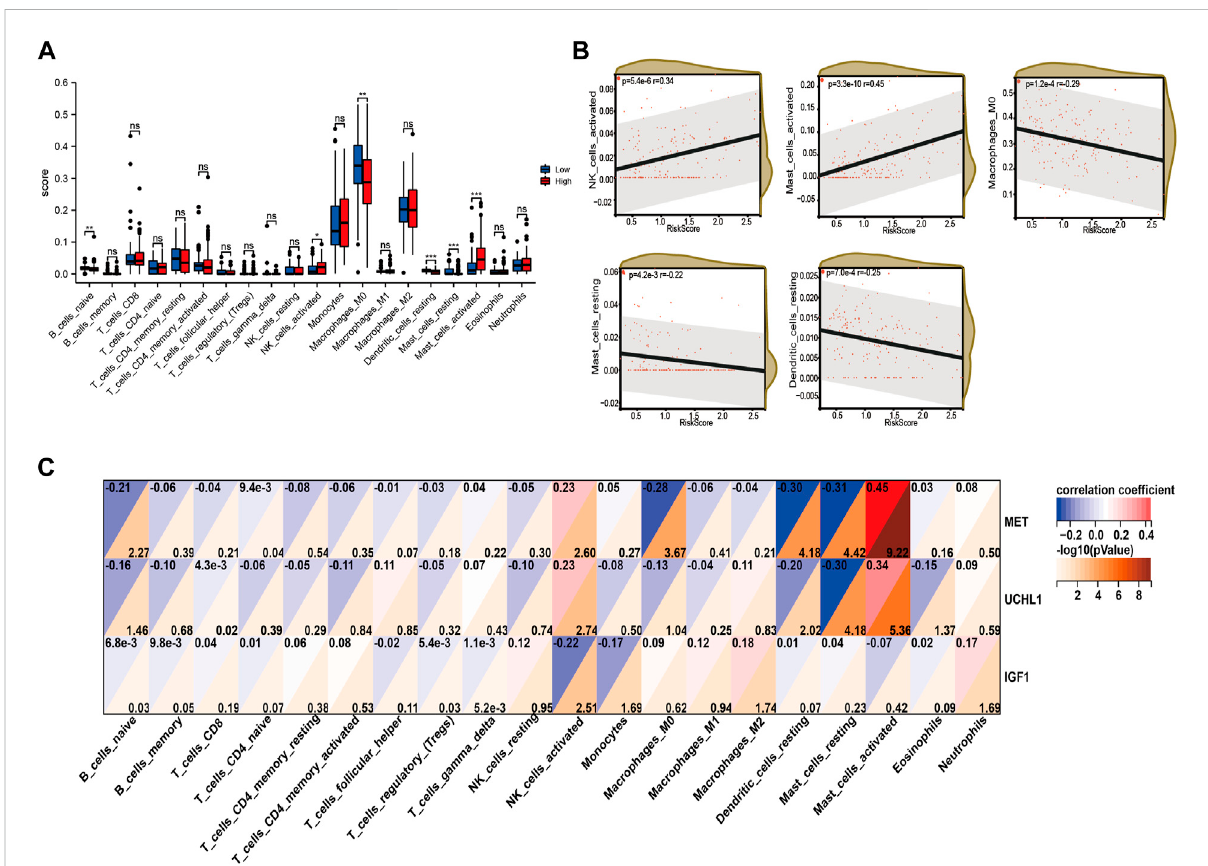
FIGURE 8 The immune in fi ltrating cell analysis based on the risk score in training cohort. (A) The in fi ltrating levels of twenty-three cells in high-risk and low-riskgroup. (B) Association betweenthein fi ltratinglevelsandriskscore. (C) Correlation betweenMET,UCHL1,IGF1,andin fi